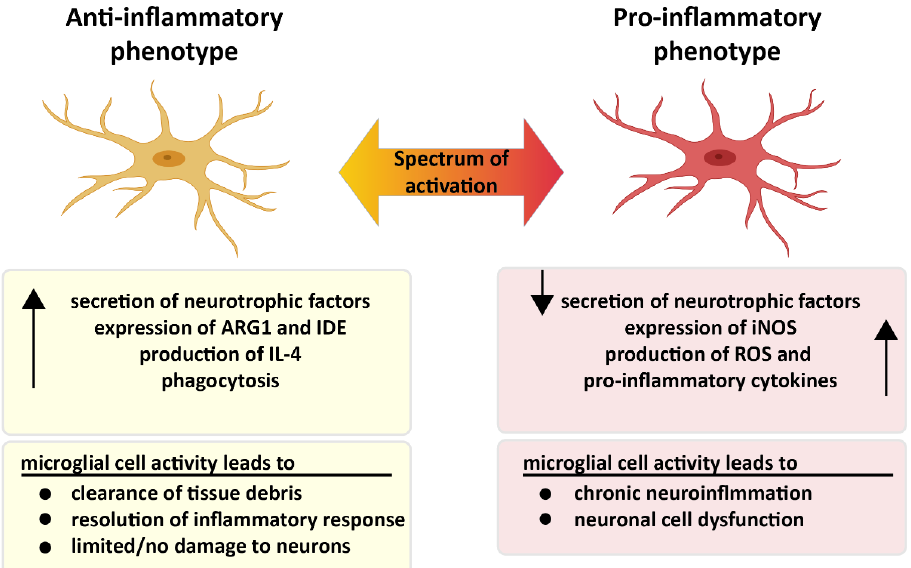
Figure 3. Two different faces of microglia. Pro- and anti-inflammatory microglia display different characteristics in the presence of microglial activation. While microglia are neuroprotective in the anti- inflammatory state, microglia in the pro-inflammatory condition trigger chronic inflammation, which leads to neuronal dysfunction. Created partially with BioRender.com (accessed on 28 June 2021).